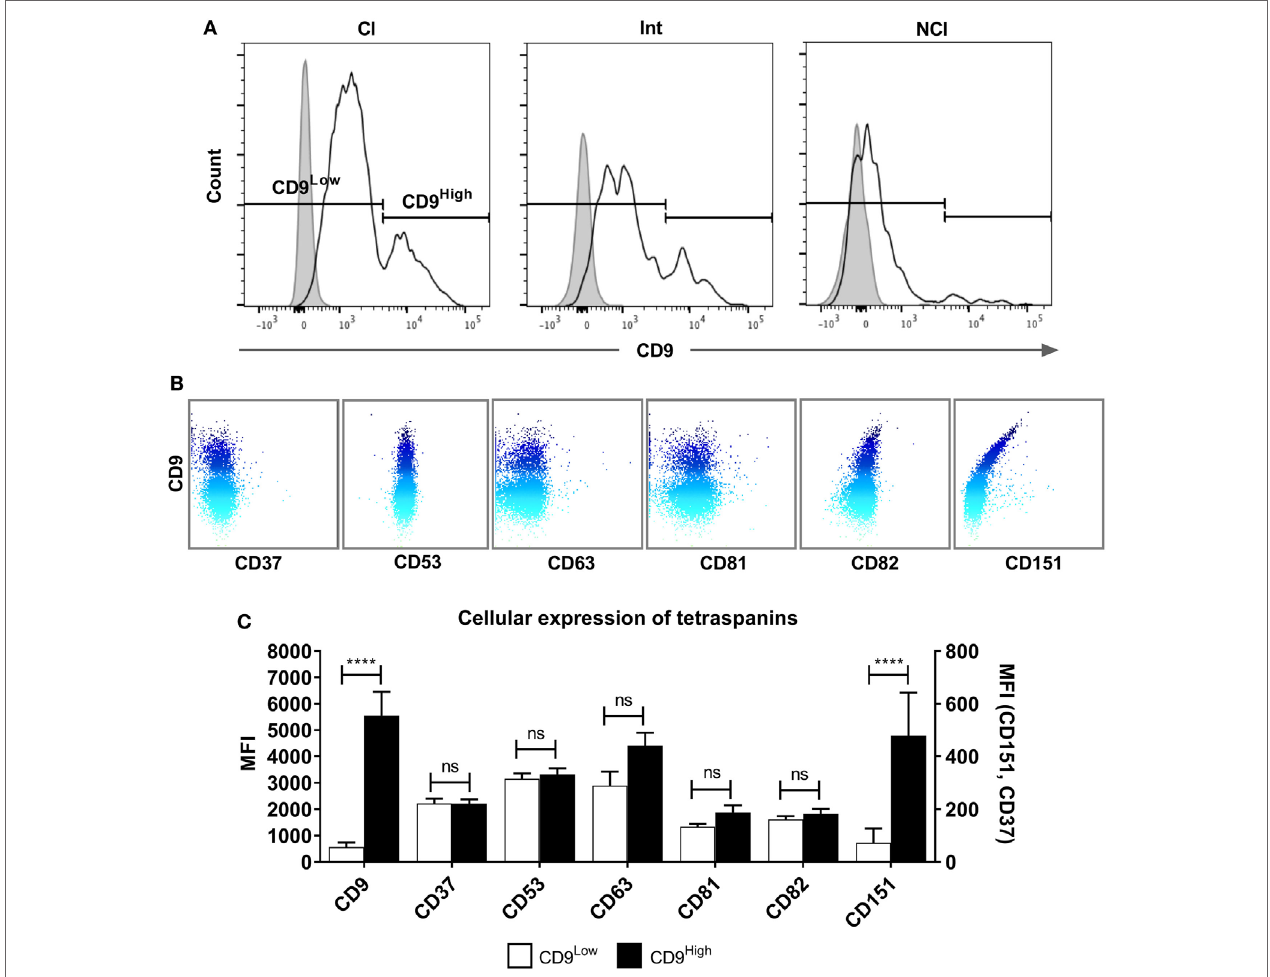
FigUre 5 | A tetraspanin CD9 High subset of classical monocytes. (a) Histograms showing the expression of CD9 on freshly isolated classical (Cl), intermediate (Int), and non­classical (NCl) monocyte subsets from a representative donor, with isotype control fluorescence shown as shaded areas. The gating strategy to separate the CD9 High and CD9 Low populations is indicated by the markers. CD9 was the only tetraspanin in the histograms to show a bimodal peak of expression. (B) Dot­plots showing the surface co­expression of tetraspanins on classical subset monocytes with CD9 from a representative donor. Increasing expression of CD9 is indicated by the blue shading. (c) Quantification of tetraspanin expression on Cl subset monocytes gated for CD9 high and low expression as shown in panel A. Bars represent the means ± SEM, from 10 different donors. Significance was tested using one­way ANOVA with Sidak’s multiple comparisons test for each pair of